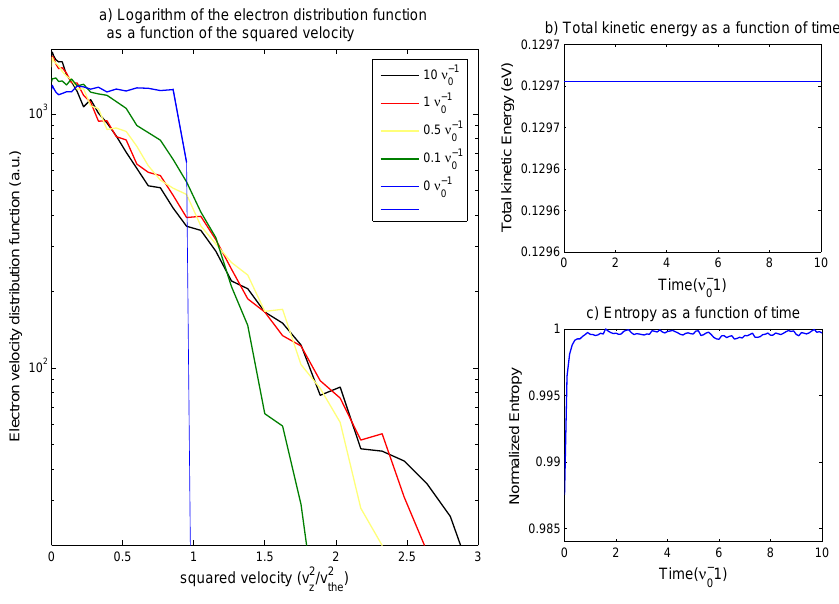
Fig. 2. Characteristics of the electrons for different times when we apply only electron/electron and electron/ion collisions: (a) the electron distribution function in logarithmic scale versus normalized squared velocity. The different colors represent different times during the simulation (b) the total kinetic energy as a function of normalized time (c) the entropy as a function of normalized time (c).